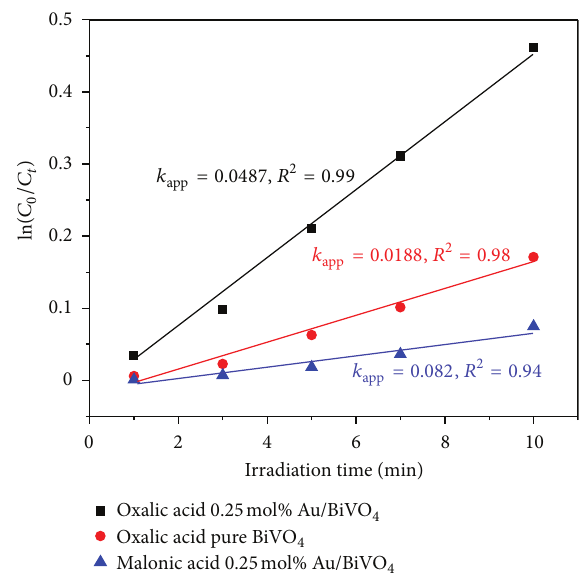
Figure 5: Plots of ln (𝐶 0 /𝐶 𝑡 ) versus irradiation time for the mineral- izations of oxalic acid over pure BiVO 4 , 0.25 mol% Au/BiVO 4 , and malonic acid over 0.25 mol% Au/BiVO 4